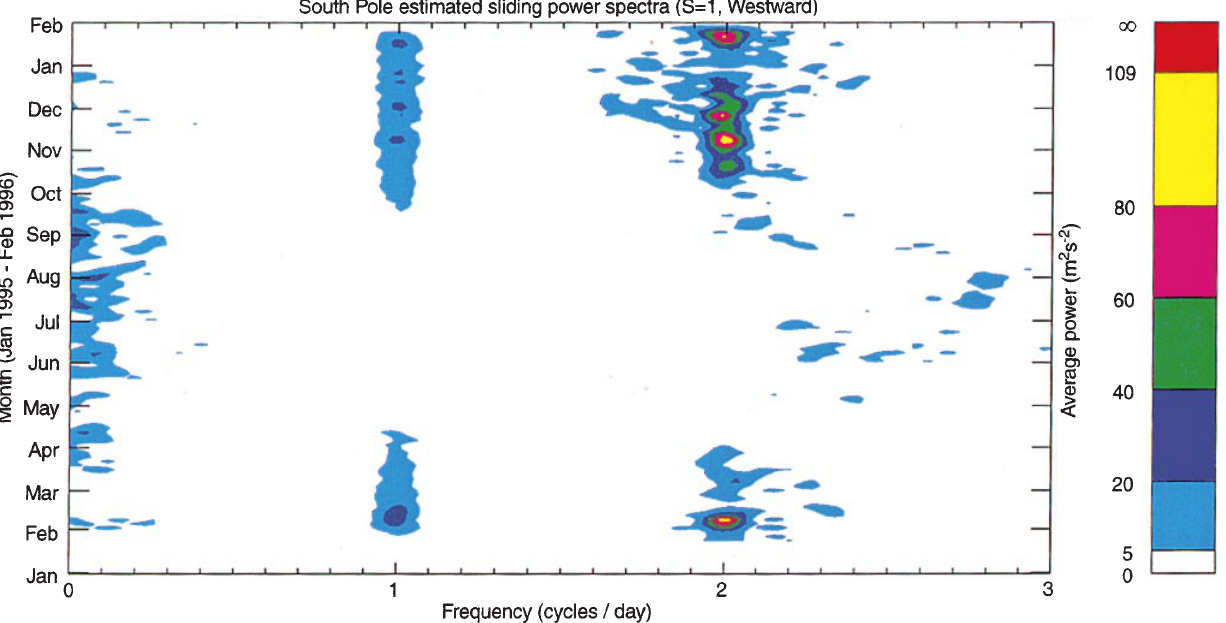
Fig. 2. Shown above is a spectrogram of the westward propagating zonal wave number one disturbances observed over the South Pole in the meridional wind